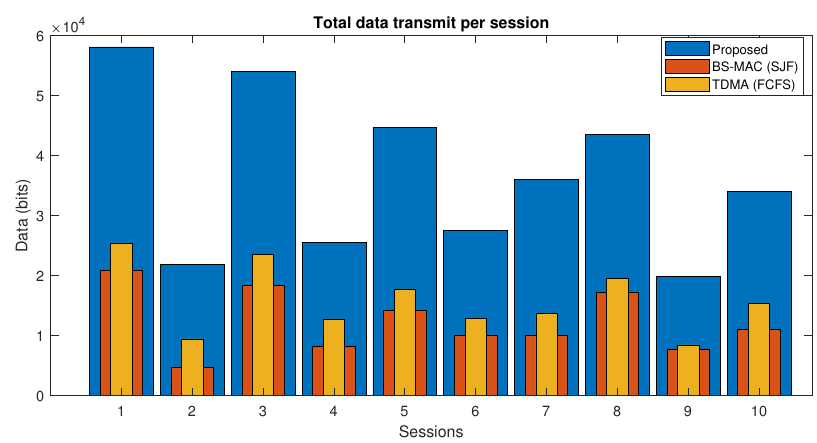
Figure 12. Data transmit per session of proposed protocol (Case 2).